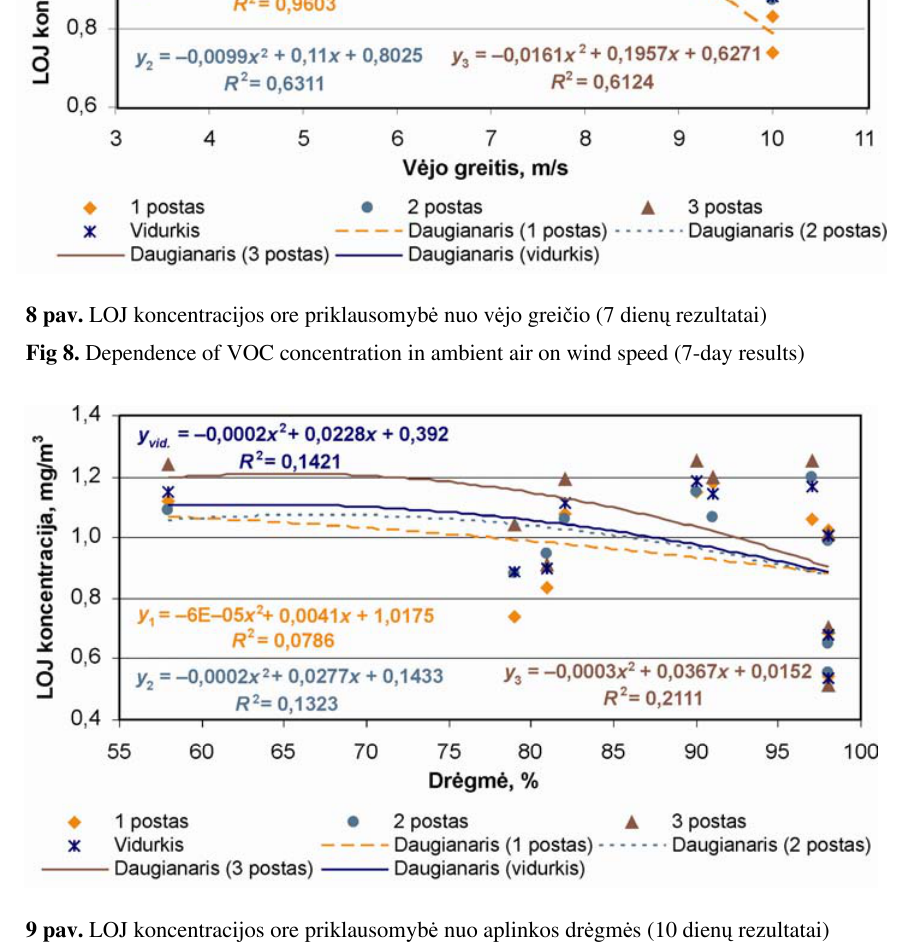
Fig 9. Dependence of VOC concentration in ambient air on relative humidity (10-day